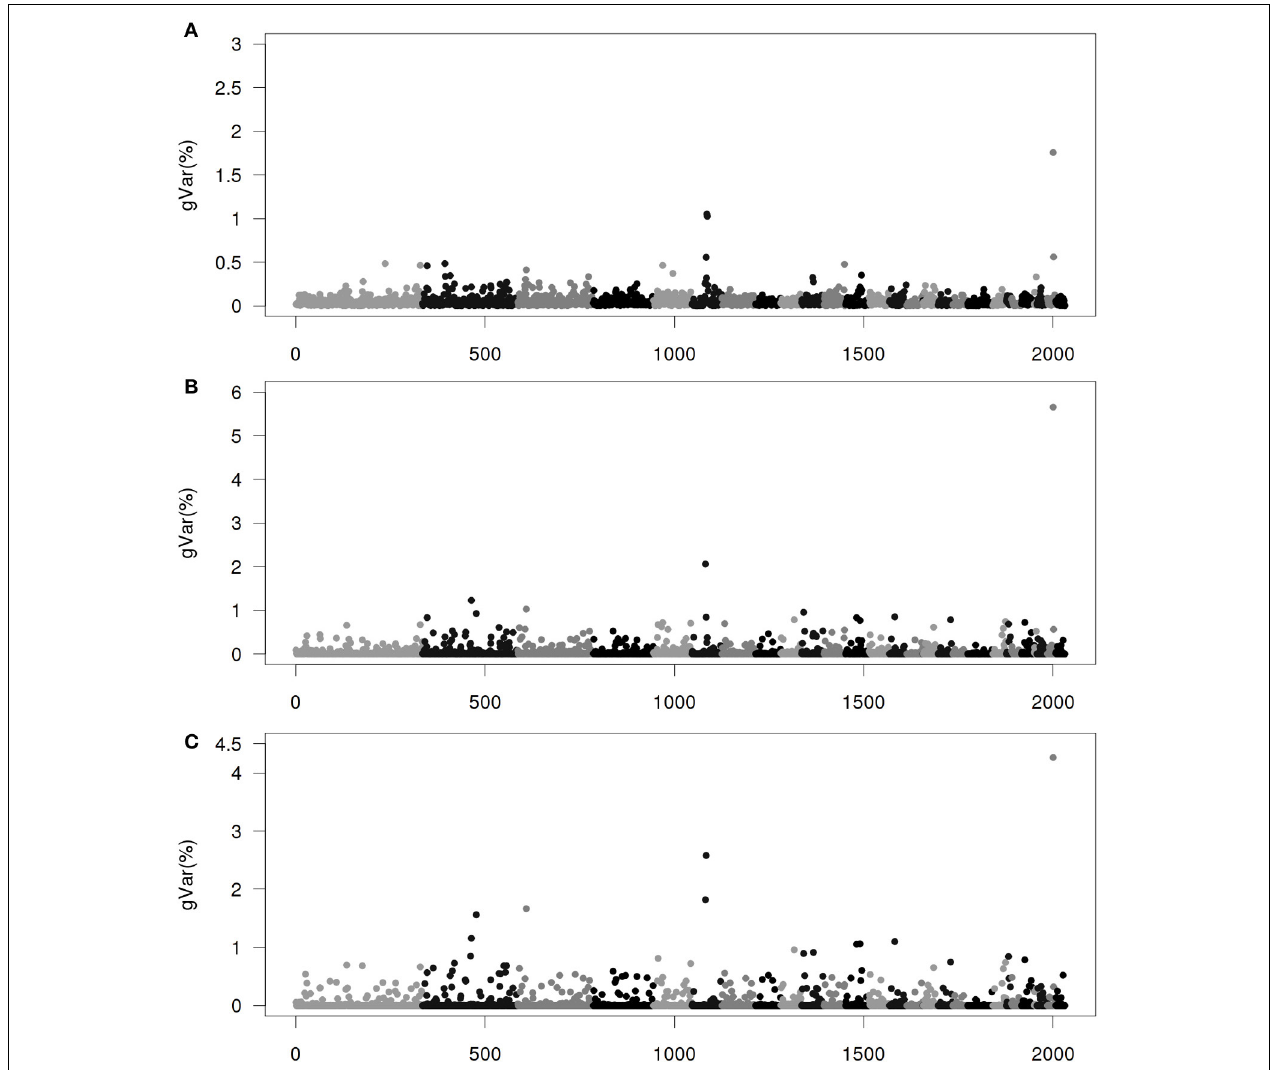
FIGURE 2 | Proportion of genetic variance of 20-SNP region under the Senarios 2 (ssGWAS2) of extended single-step genomic BLUP (ssGBLUP). (A) The first iteration (ssGWAS2/1). (B) The third iteration